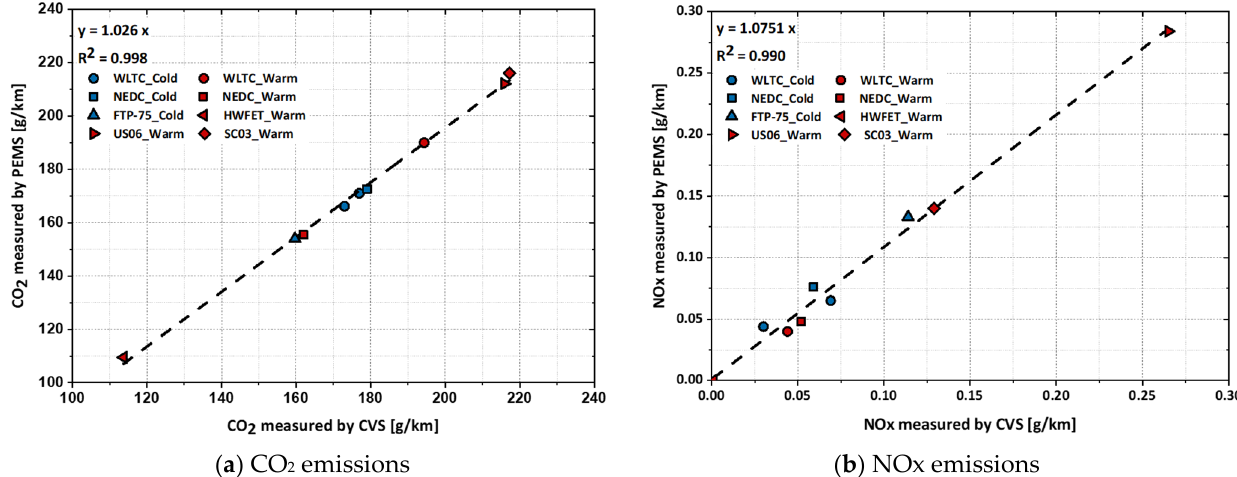
Figure 6. Comparison of exhaust emissions measured with the CVS and PEMS equipment.